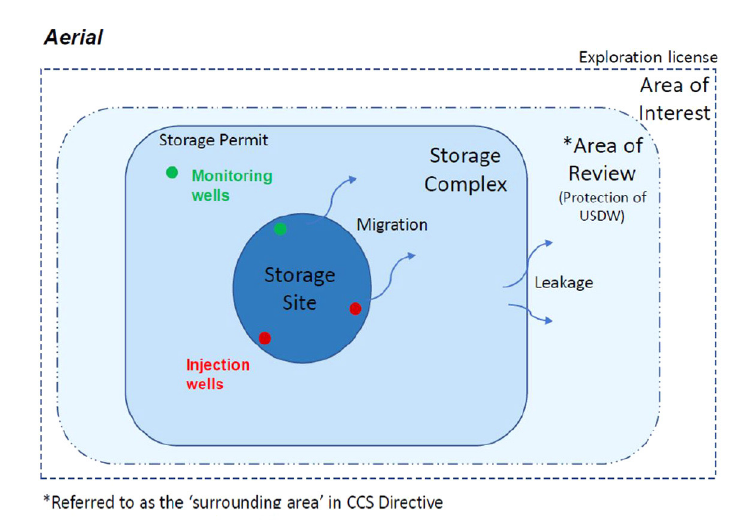
Fig. 14. – Conceptual map view of the CO 2 storage site/complex